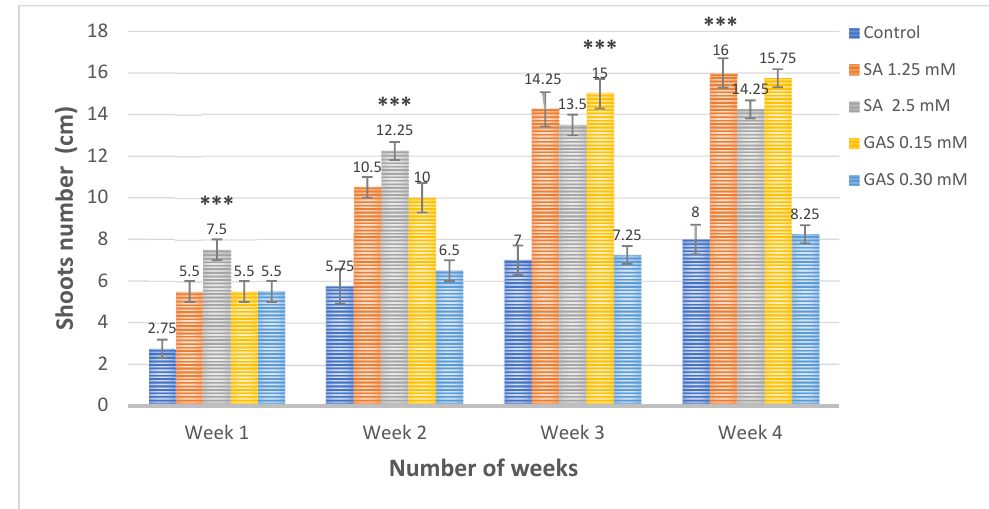
Figure 8. The average number of shoots in infected tissue cultured potato plantlets Solanum tuberosum L. selena with PLRV in response to salicylic acid (1.25 and 2.5 mM) and Glycyrrhizic Acid ammonium salt (0.15 and 0.30 mM) nanoparticles compared to positive control after one week. Two-way ANOVA was used to analyze the data. *** p < 0.001 show significant variations in the number of shoots.